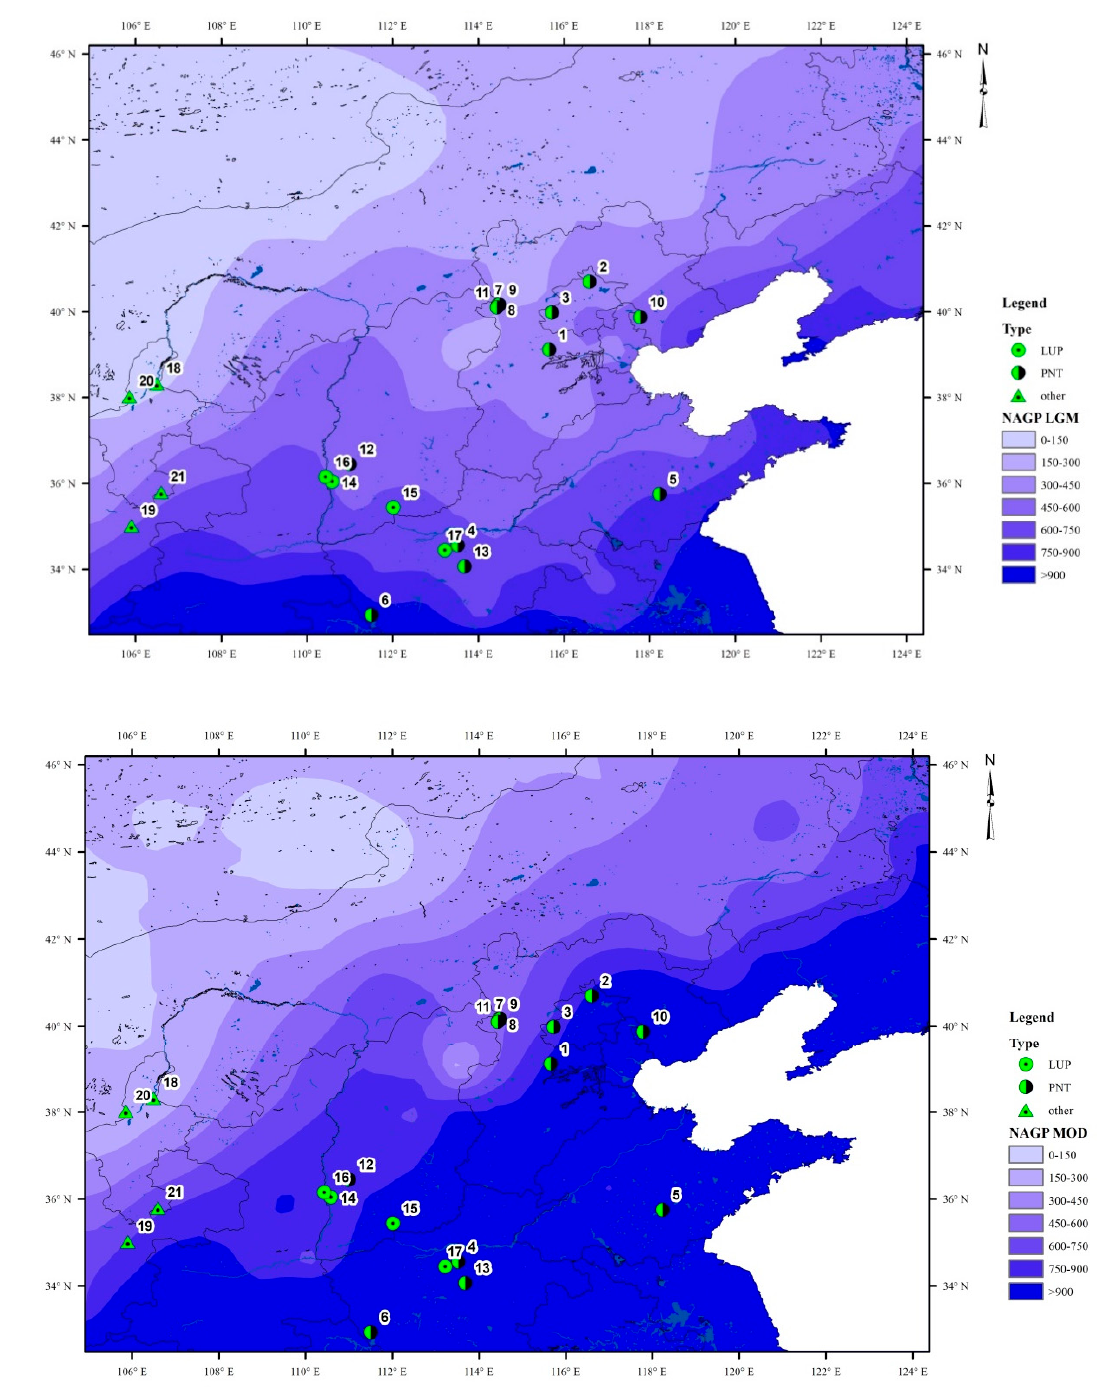
Figure 4. Archaeological sites dated to the Pleistocene to Holocene transition on the maps of net above–ground productivity (NAGP) in Northern China under LGM and modern climatic conditions.